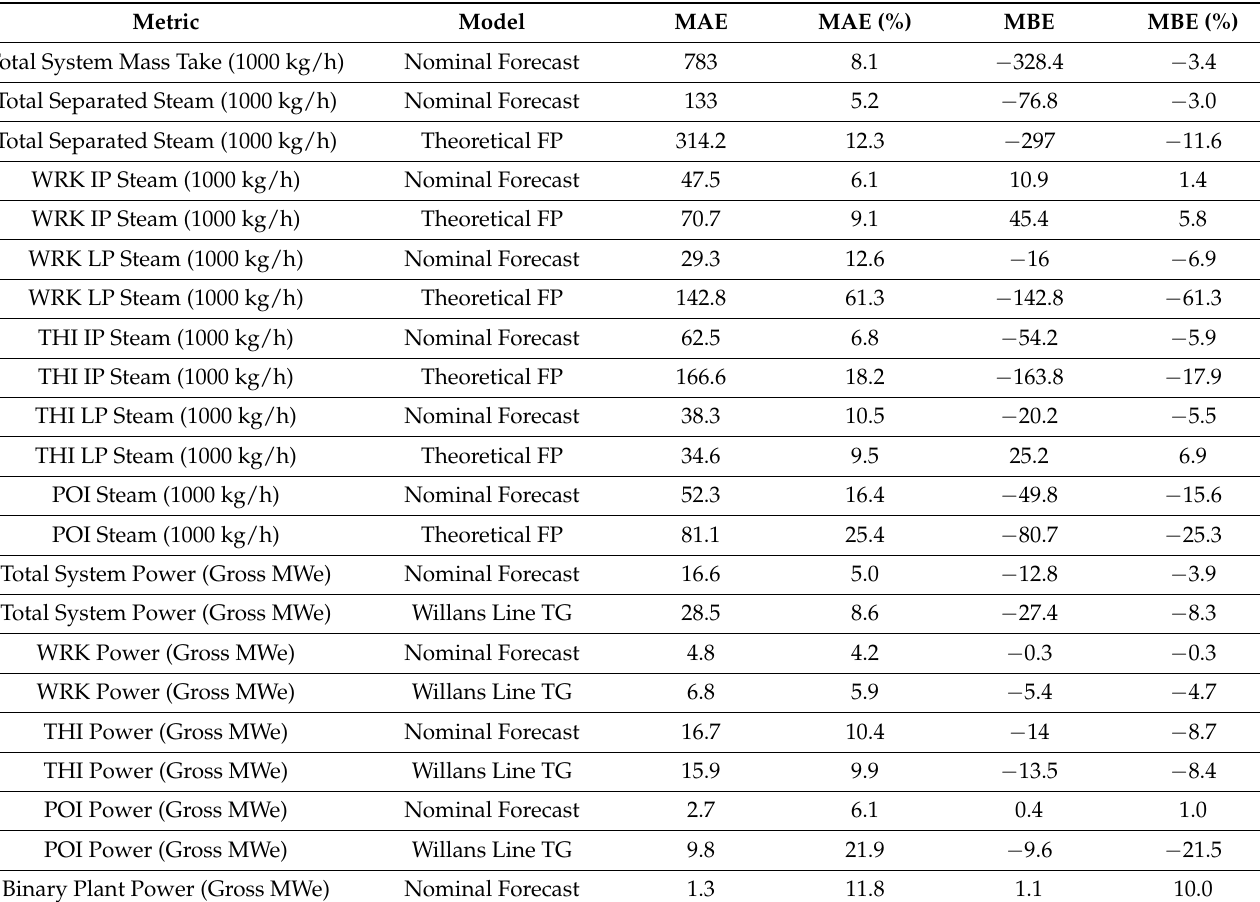
Table 2. Comparison of results of steamfield model components in the GOOML environment based on mean bias error (MBE) and